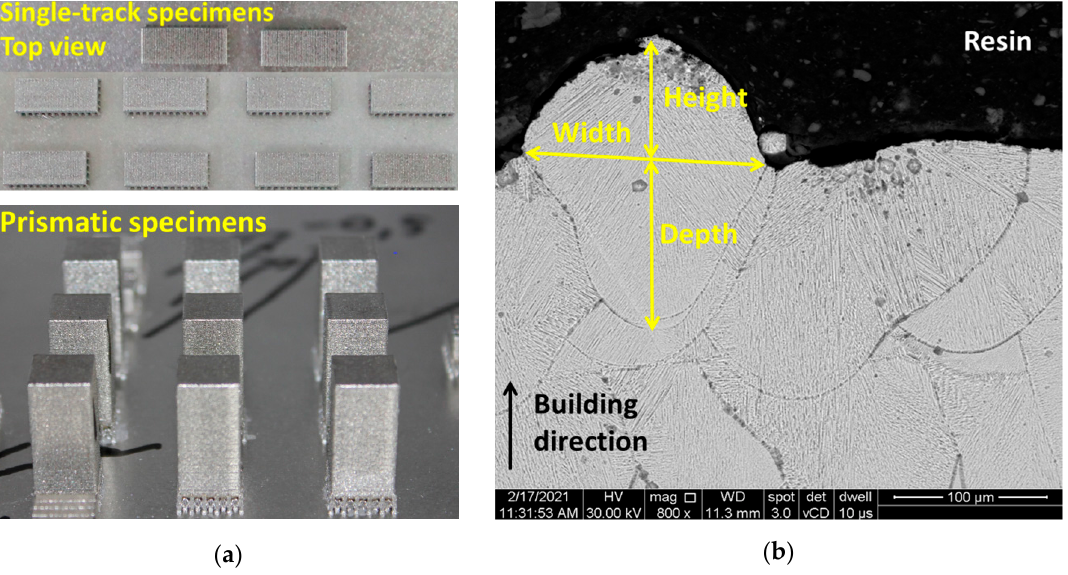
Figure 1. Prismatic specimens design used for the density measurements and melt pool analysis: ( a ) single-track and density specimens and ( b ) representation of the measured melt pool width, height, and depth of penetration on the cross section of single-track specimens.